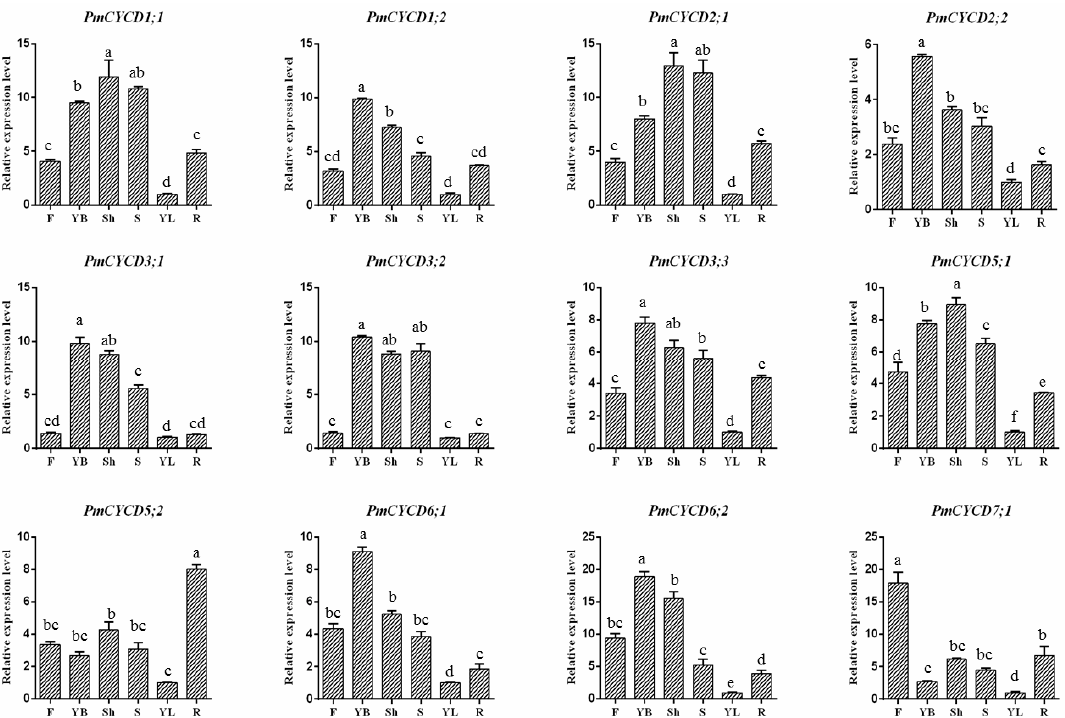
Figure 5. Expression analysis of 12 PmCYCD genes under different tissues by qRT-PCR. The relative quantification method (2 − ∆∆ CT ) was used to evaluate quantitative variation under different tissues. Error bars represent standard error for three replicates. Different lowercase letters in column differed significantly based on Tukey’s test ( p < 0.05) after one-way ANOVA. F, flower; YB, young buds; Sh, shoot; S, stem; YL, young leaf; R, root.